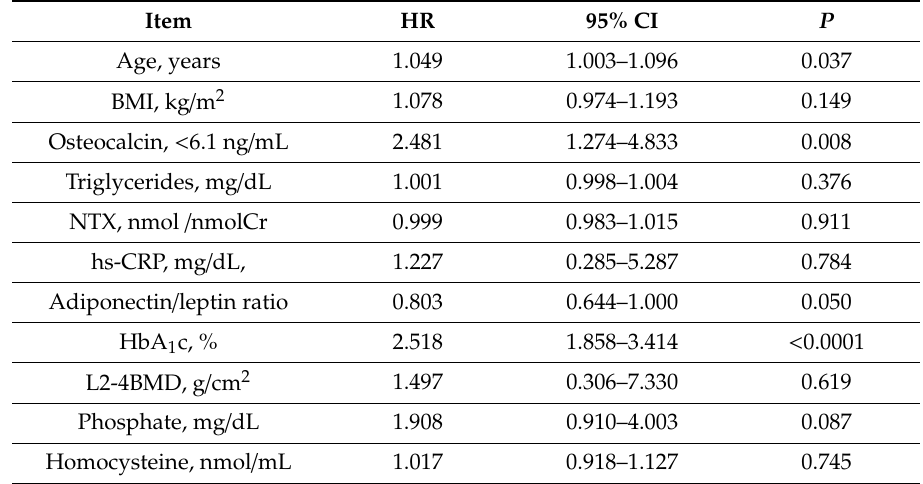
Table 4. Multivariate Cox proportional hazard model for incidence of type 2 diabetes mellitus adjusted for confounders. (Adapted from